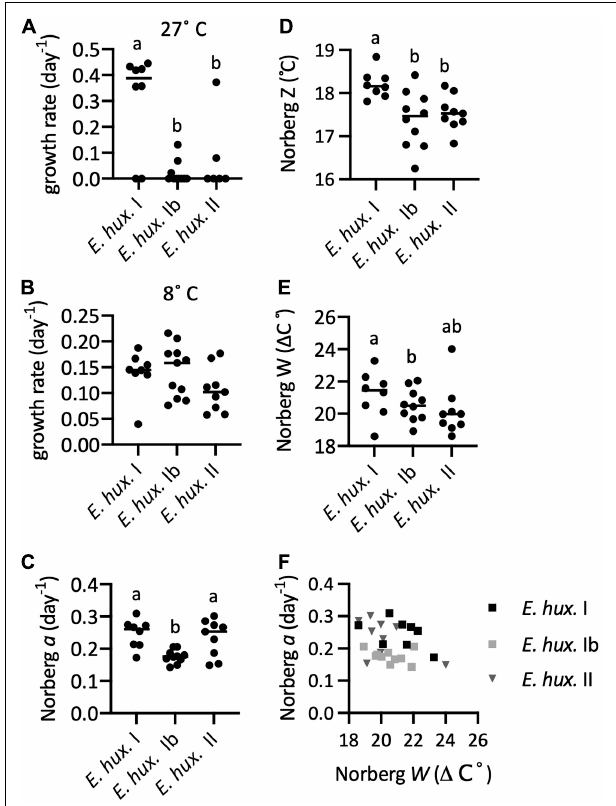
FIGURE 8 | Thermal reaction norms calculated from TPCs in Experiment 2. (A) Growth rate at 27 ◦ C. (B) Growth rate at 8 ◦ C. (C–E) Reaction norms from Norberg fit. (C) The Norberg a performance (height) parameter. (D) Norberg Z (competitive optimum temperature). (E) Norberg niche width W . (F) Norberg growth (height) a vs width W for Experiment